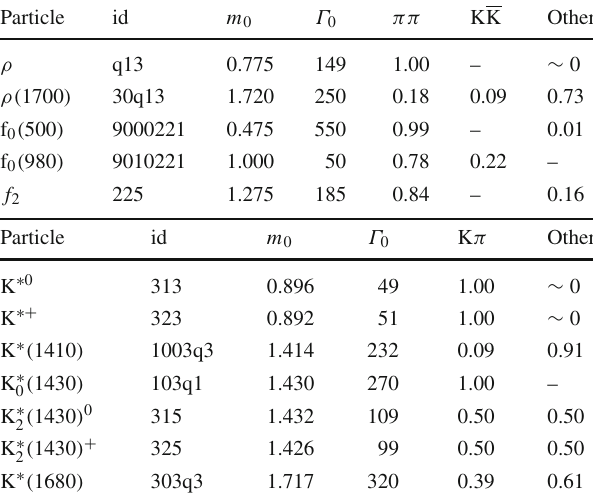
Table 6 Implemented meson resonances, including nominal mass (GeV) and width (MeV), and branching ratios for some main decay channels